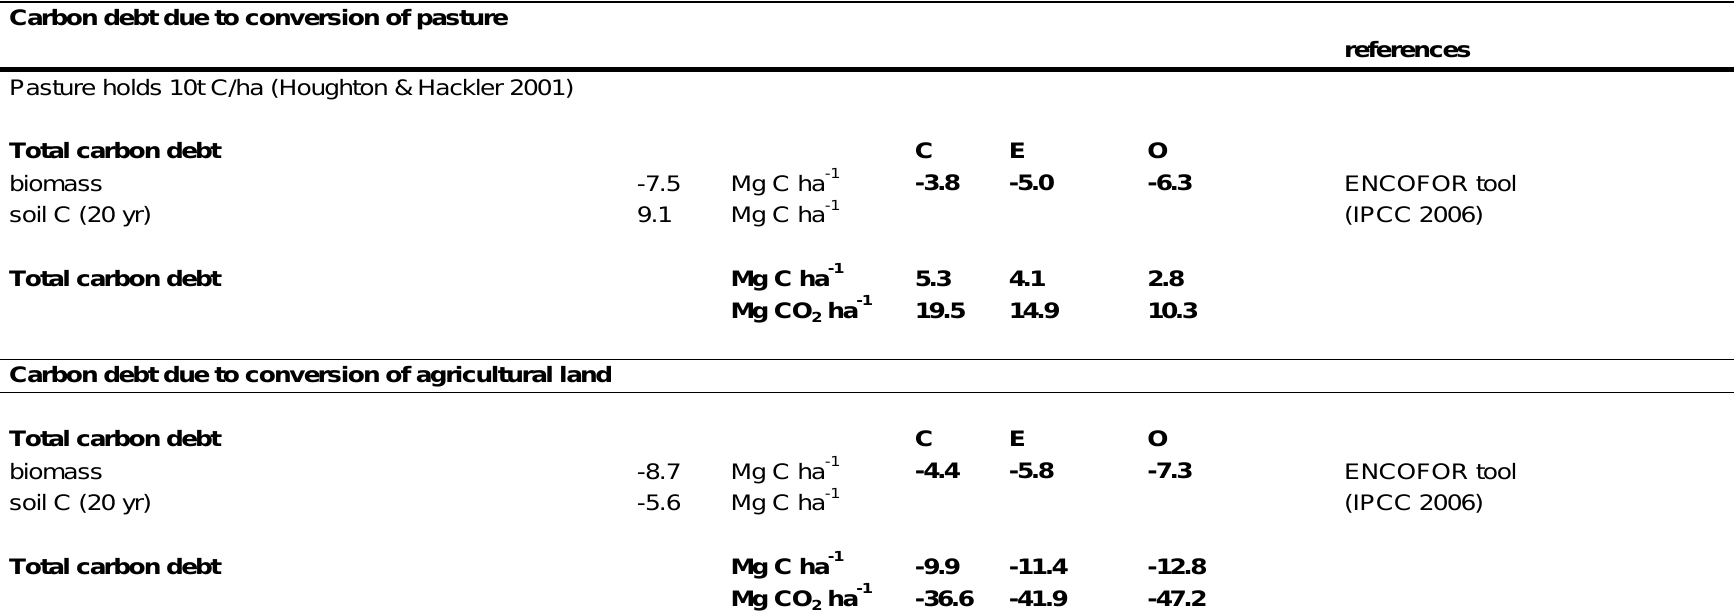
Table A4.3. Continued Carbon debt calculation of Chiapas, Mexico